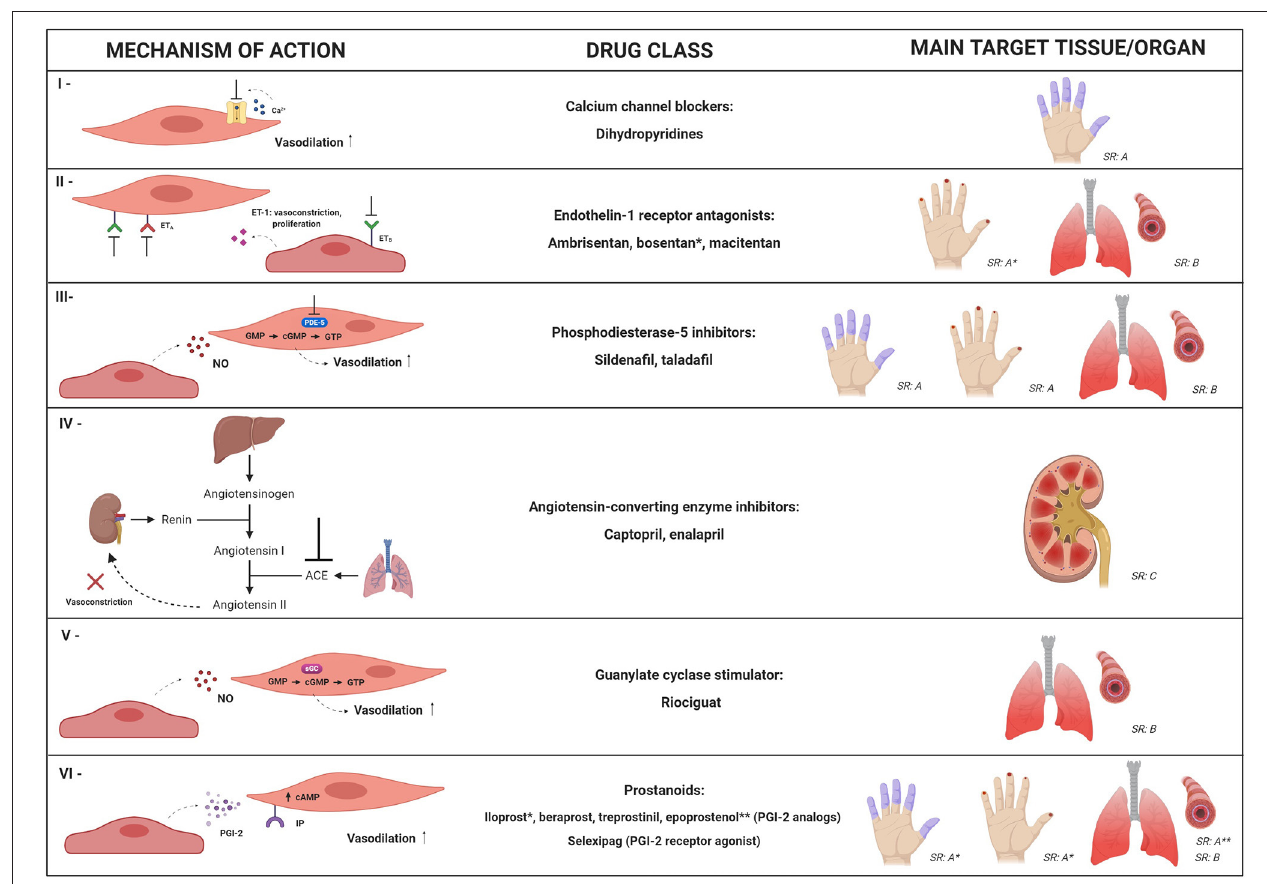
FIGURE 2 | Mechanistic targets of the main pharmacological approaches for systemic sclerosis-related vasculopathy. Multiple drug options, with different mechanistic approaches, can be used for management of vascular manifestations in SSc patients. This figure summarizes mechanisms and clinical indications for: calcium channel blockers (I); endothelin-1 receptor antagonists (II); phosphodiesterase-5 (PDE-5) inhibitors (III); angiotensin-converting enzyme (ACE) inhibitors (IV); guanylate cyclase stimulator – riociguat (V) and prostanoids (VI). SR: strength of recommendation; SR: A , SR: B or SR: C according to the European League